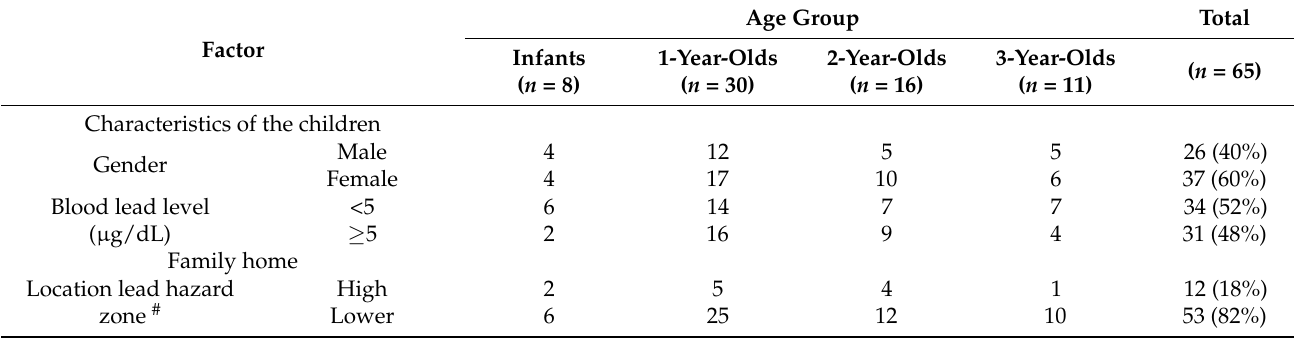
Table 1. Summary of the key characteristics of the study subjects and the primary place they visited outside the family home, Broken Hill,